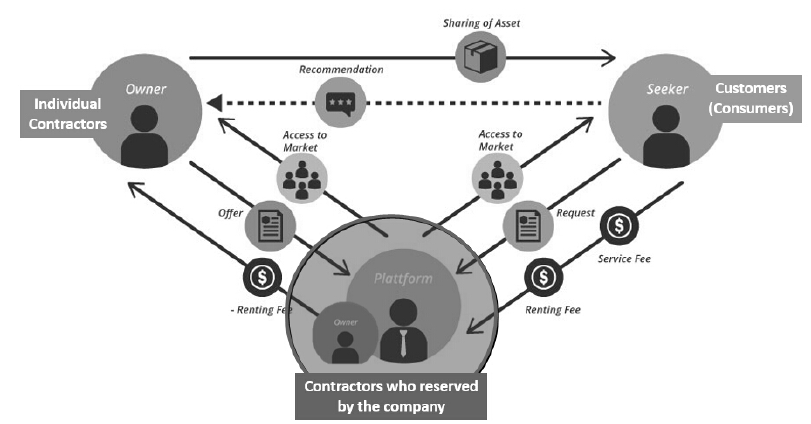
Figure 1. Sharing Economy with Two Types of Contractors